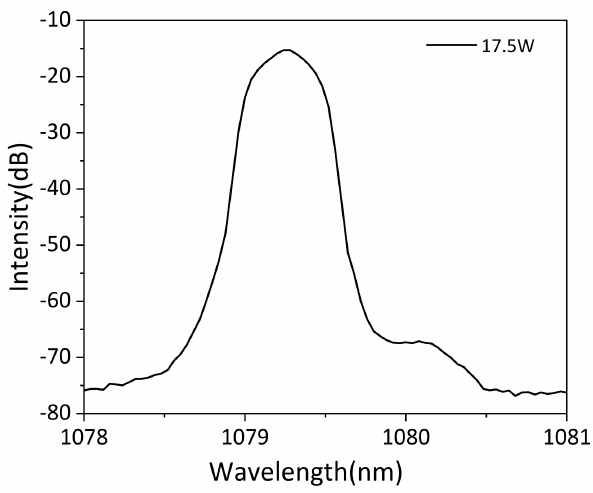
Figure 2. The output spectrum of the seed